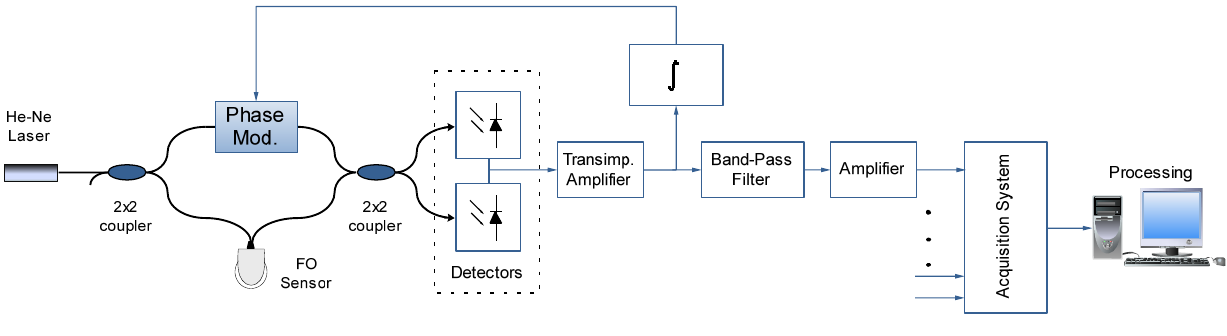
Figure 3. Diagram of the optoelectronic instrumentation